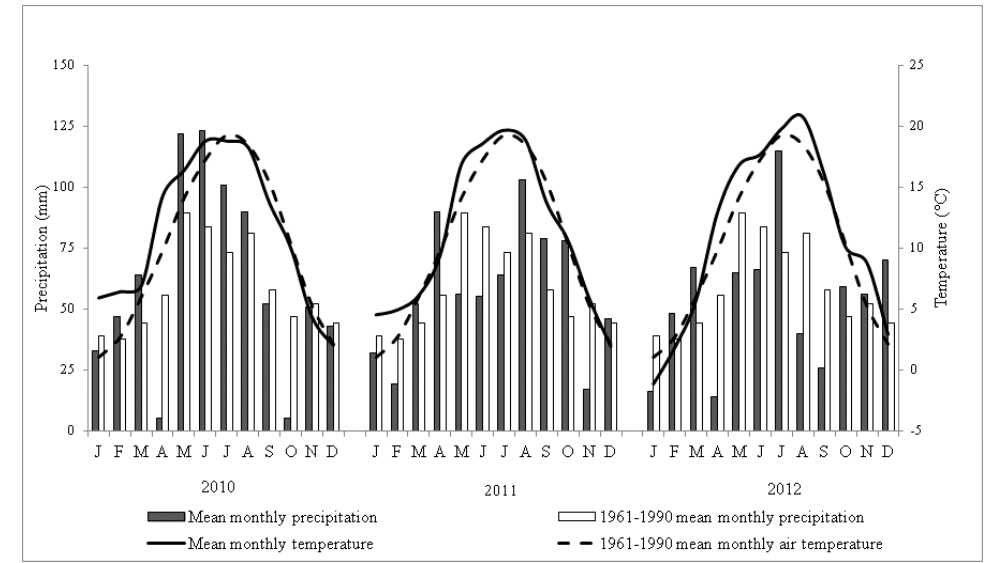
Figure 1. Climate data for the Stifterhof Research Plot 2010 to